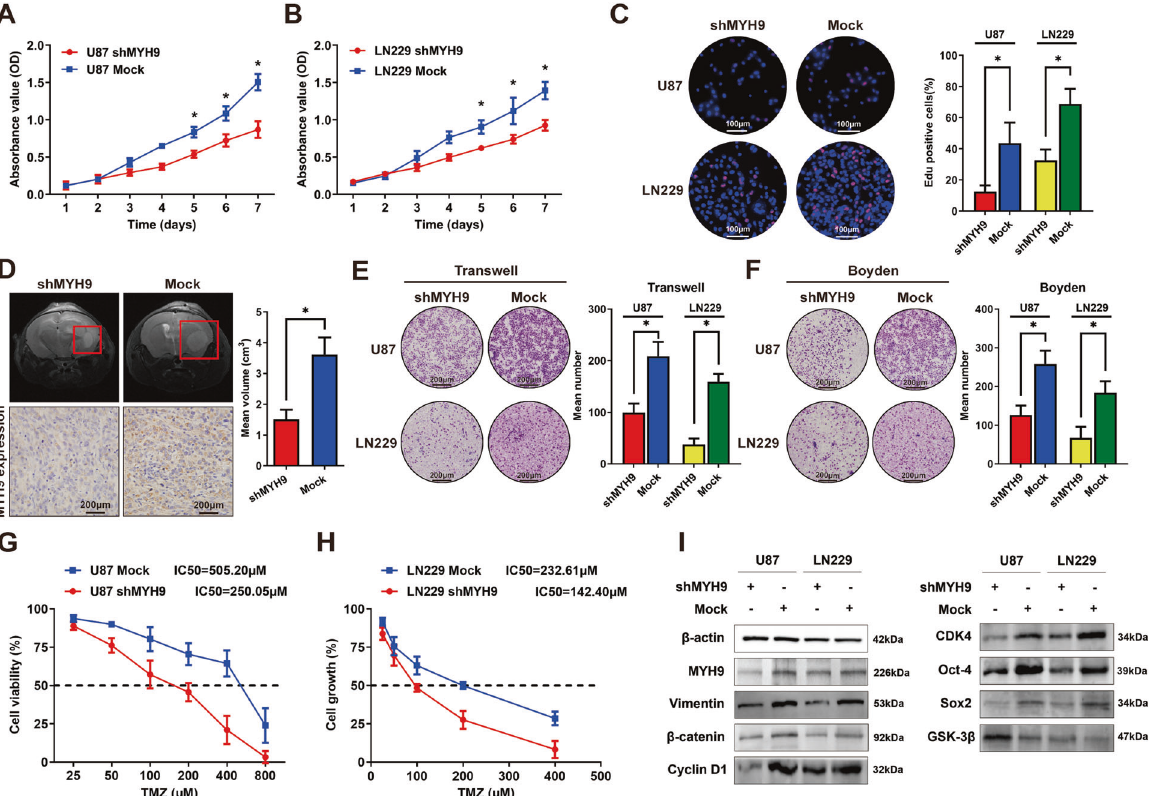
Fig. 3 MYH9 promoted proliferation, invasion, migration, and TMZ resistance in gliomas. A , B MTT assays showed MYH9 downregulation observably inhibited the cell growth. C Edu incorporation assays showed knockdown of MYH9 decreased the cell proliferation by blocking G1/ S phase transition in glioma cells. D Intracranial orthotopic transplantation suggested knockdown of MYH9 inhibited the tumorigenesis in gliomas. E , F Transwell ( E ) and Boyden ( F ) chamber assays con fi rmed knockdown of MYH9 inhibited the ability of cell invasion and migration. G , H Dose – response curves were delineated for TMZ treatment in shMYH9 cells and the control groups to identify the role of MYH9 in chemoresistance. I Western blot assay con fi rmed the change of the downstream pathway of